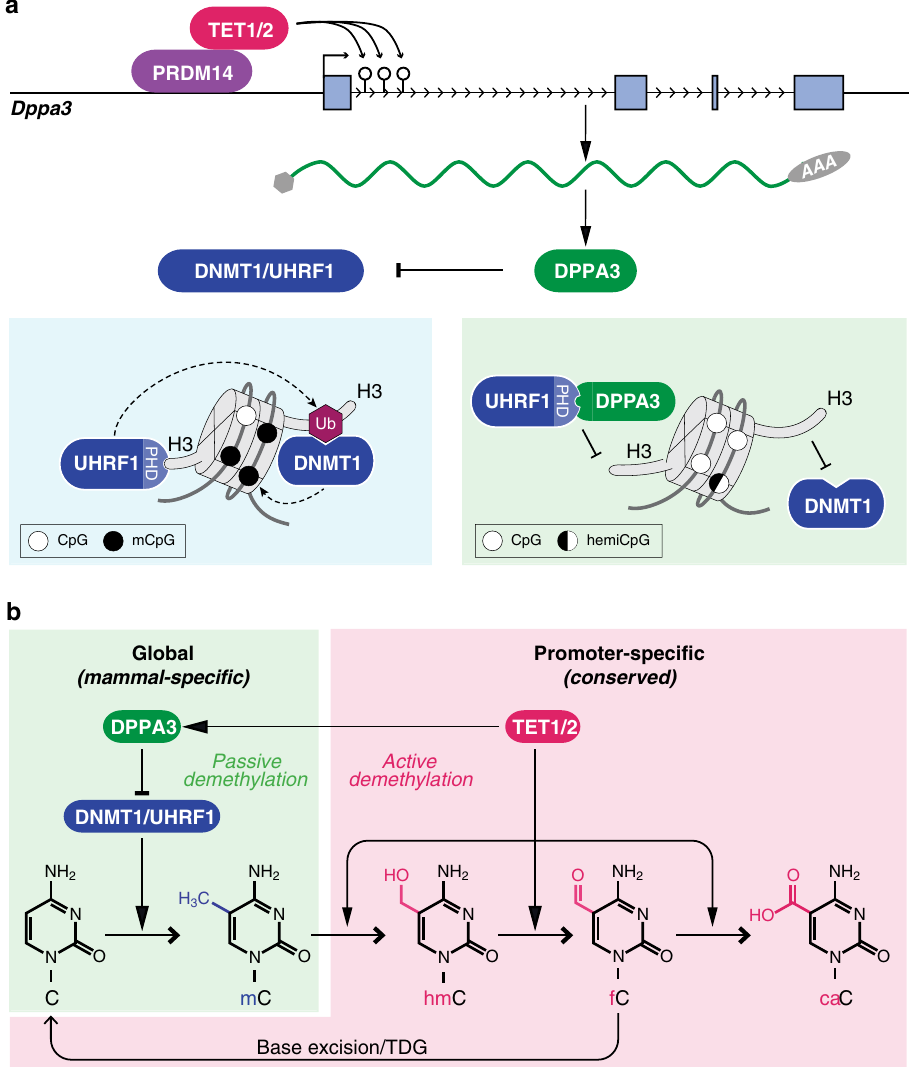
Fig. 8 Recent evolution of a TET-controlled and DPPA3-mediated pathway of DNA demethylation in boreoeutherian mammals. a In mammals, TET1 and TET2 are recruited by PRDM14 to the promoter of Dppa3 where they promote active DNA demethylation and transcription of Dppa3 . In most cellular contexts, high fi delity maintenance DNA methylation is guaranteed by the concerted activities of UHRF1 and DNMT1 at newly replicated DNA. Both the recruitment and activation of DNMT1 critically depend on the binding and ubiquitination of H3 tails by UHRF1. In naïve pluripotent cells, DPPA3 is expressed and inhibits maintenance DNA methylation by directly binding UHRF1 via its PHD domain and releasing it from chromatin. b TET1 and TET2 control DNA methylation levels by two evolutionary and mechanistically distinct pathways. TET-mediated active demethylation regulates focal DNA methylation states e.g. developmental genes and is evolutionarily conserved among vertebrates. The use of TET proteins to promote global demethylation appears to be speci fi c to mammalian pluripotency and mediated by the recently evolved Dppa3